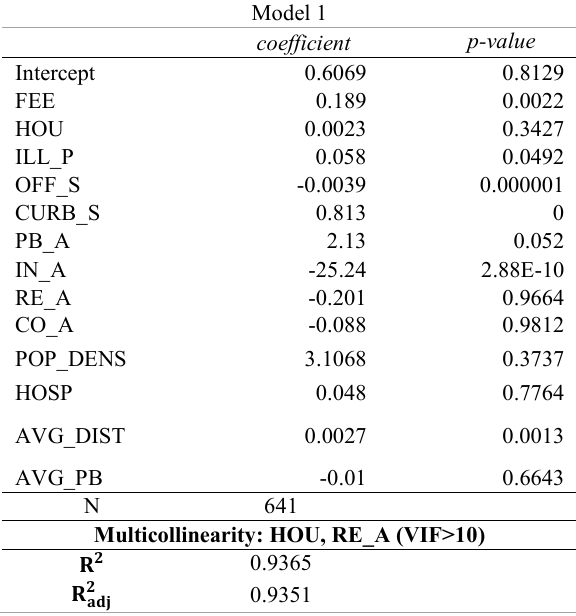
Table 2 Estimated Coefficients of Model 1: Model 1 shows a